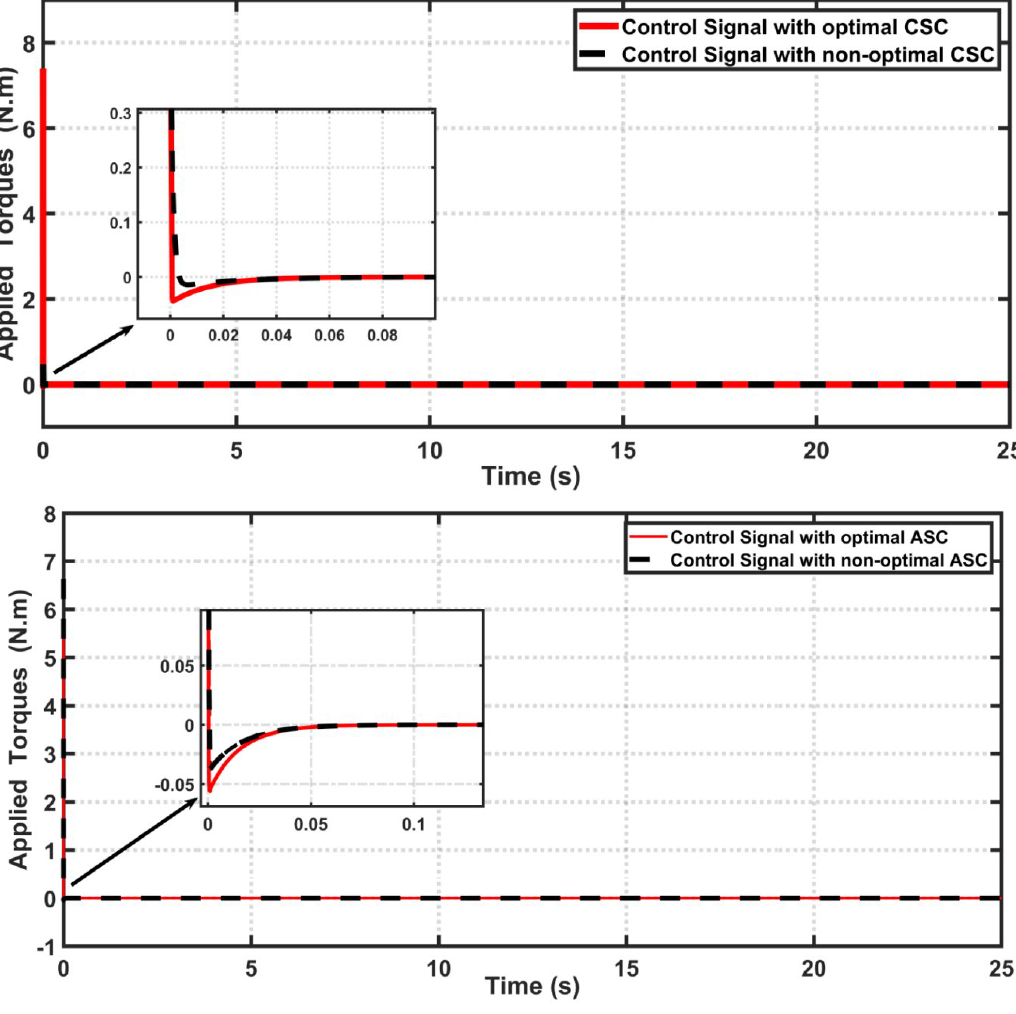
Figure 11. Control signals generated by optimal and non-optimal CSC and ASC.